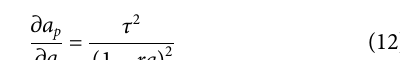
Frontiers in Earth Science |